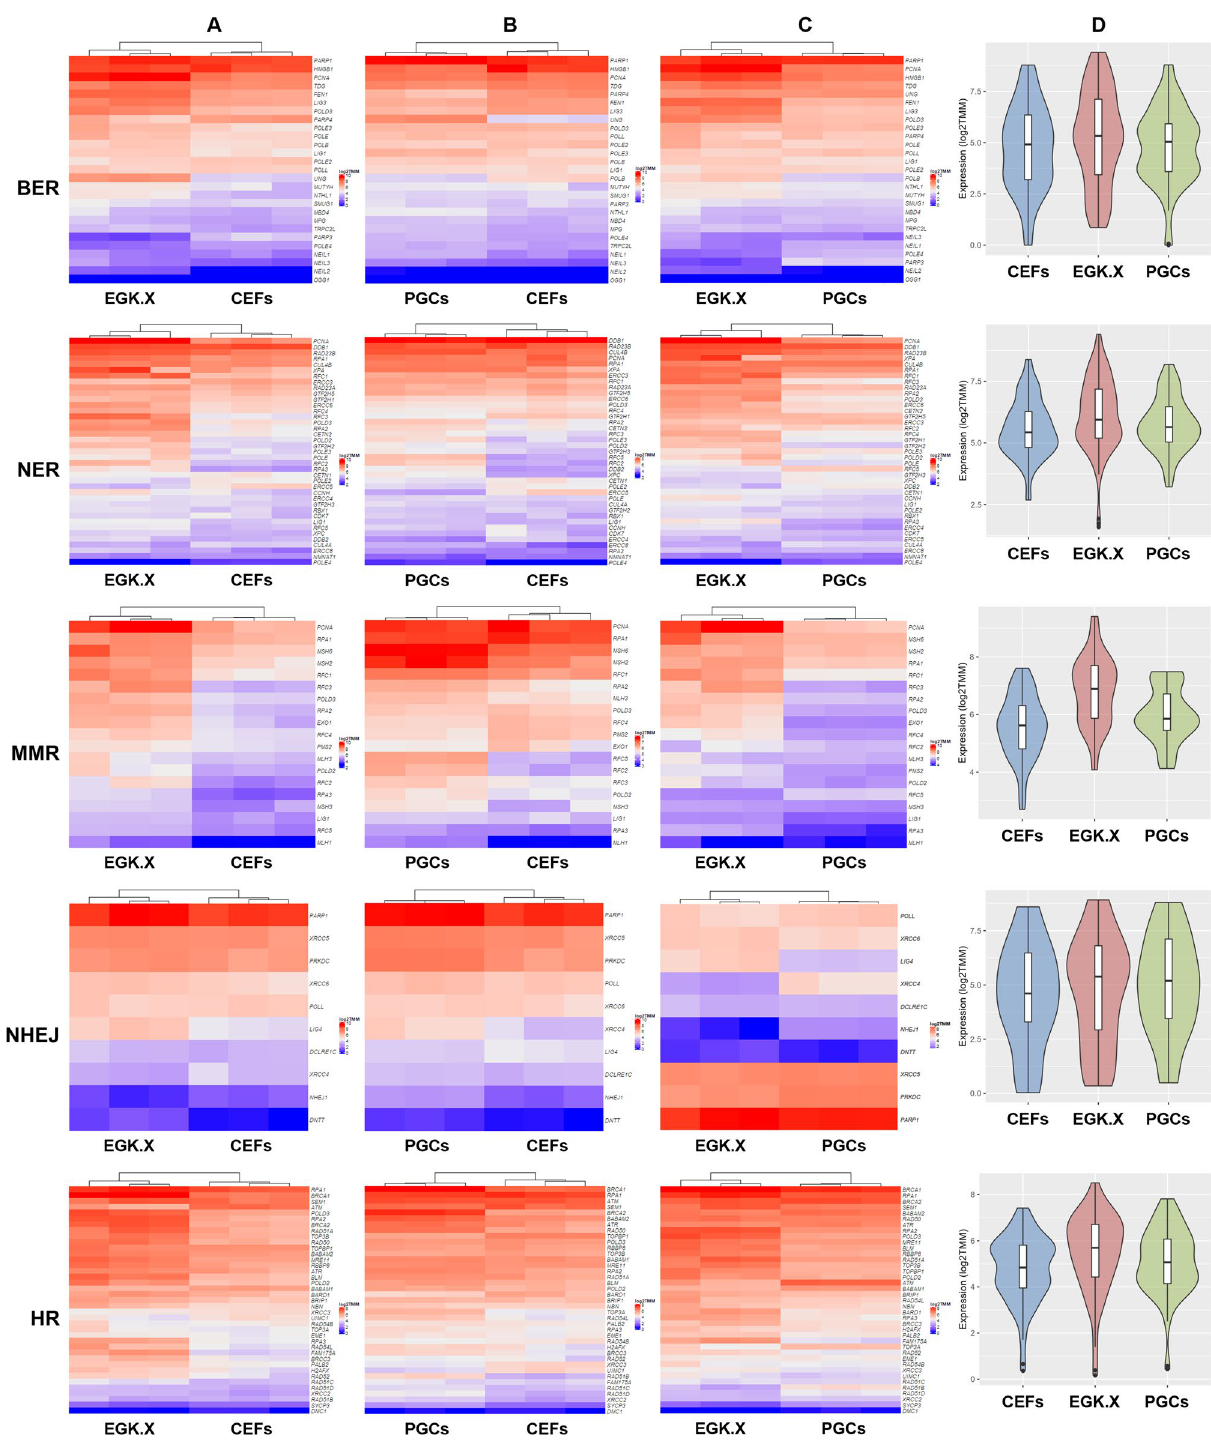
Figure 2. Visualization of the expression of DNA repair pathway genes. ( A–C ) Heatmaps using log 2 TMM values of the normalized read counts of each DNA repair pathway genes in CEFs and EGK.X blastoderms ( A ), CEFs and PGCs ( B ), and EGK.X blastoderms and PGCs ( C ) were prepared separately for better visualization. ( D ) Violin plots were prepared with the log 2 TMM values to visualize the overall expression of DNA repair pathway genes in CEFs, EGK.X blastoderms, and